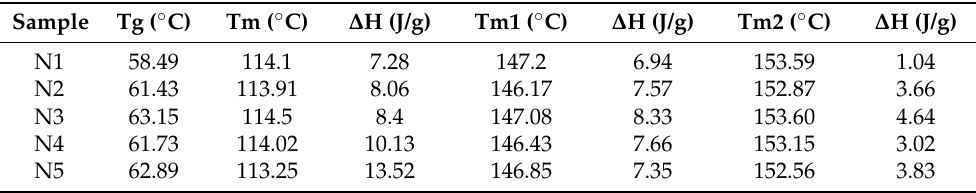
Table 3. DSC Results of PLA/PBS/CNC